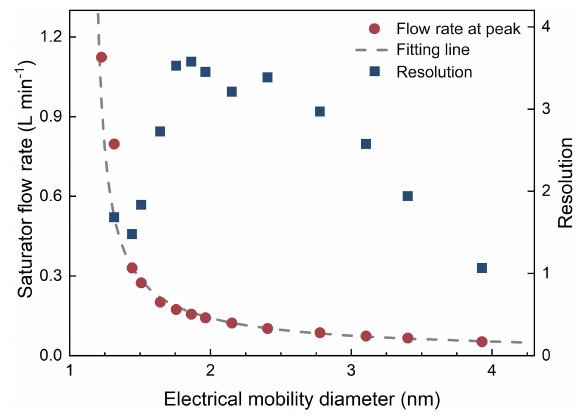
Figure 2. The saturator flow rate at kernel function peak and the resolution as functions of the particle diameter. Note that the reso- lution is defined using the saturator flow rate, but the horizontal axis is shown in the particle diameter corresponding to the peak saturator flow rate for a more straightforward